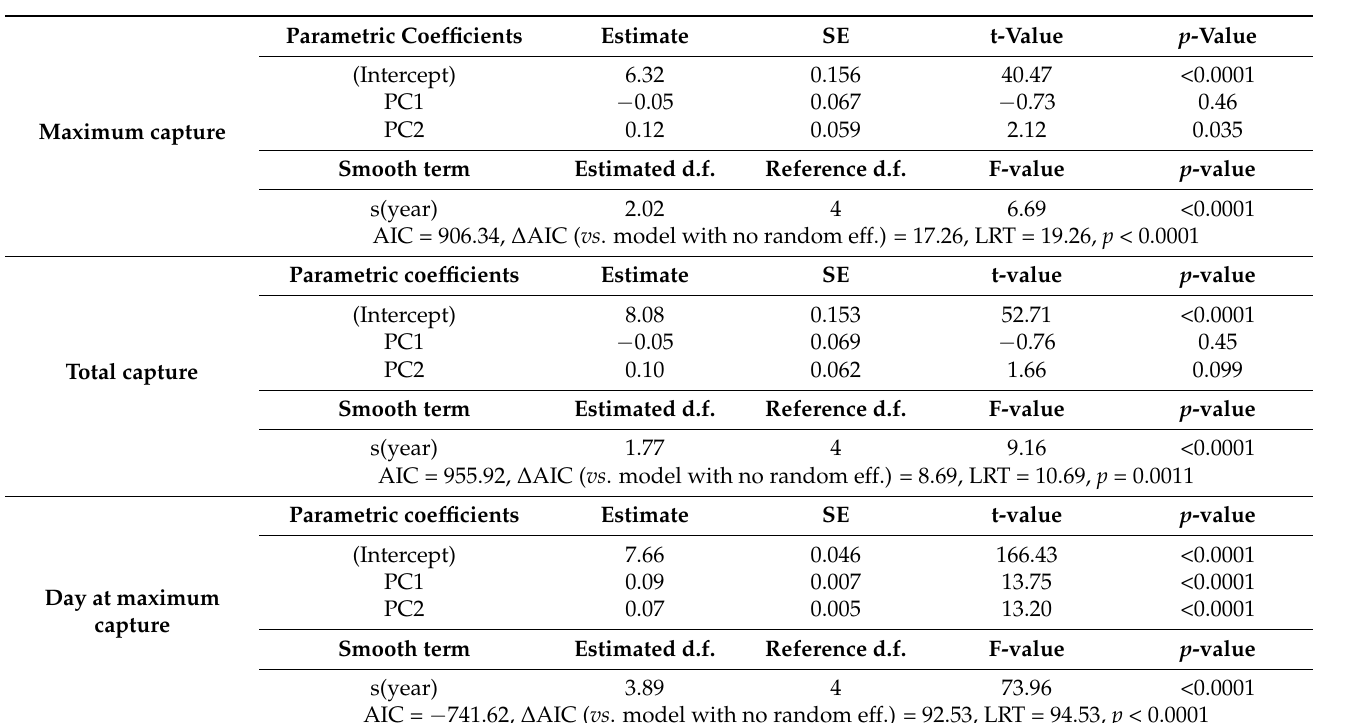
Table 2. Results of generalized additive mixed-effect models for maximum capture, total capture, day at maximum capture, day at first capture, and day at last